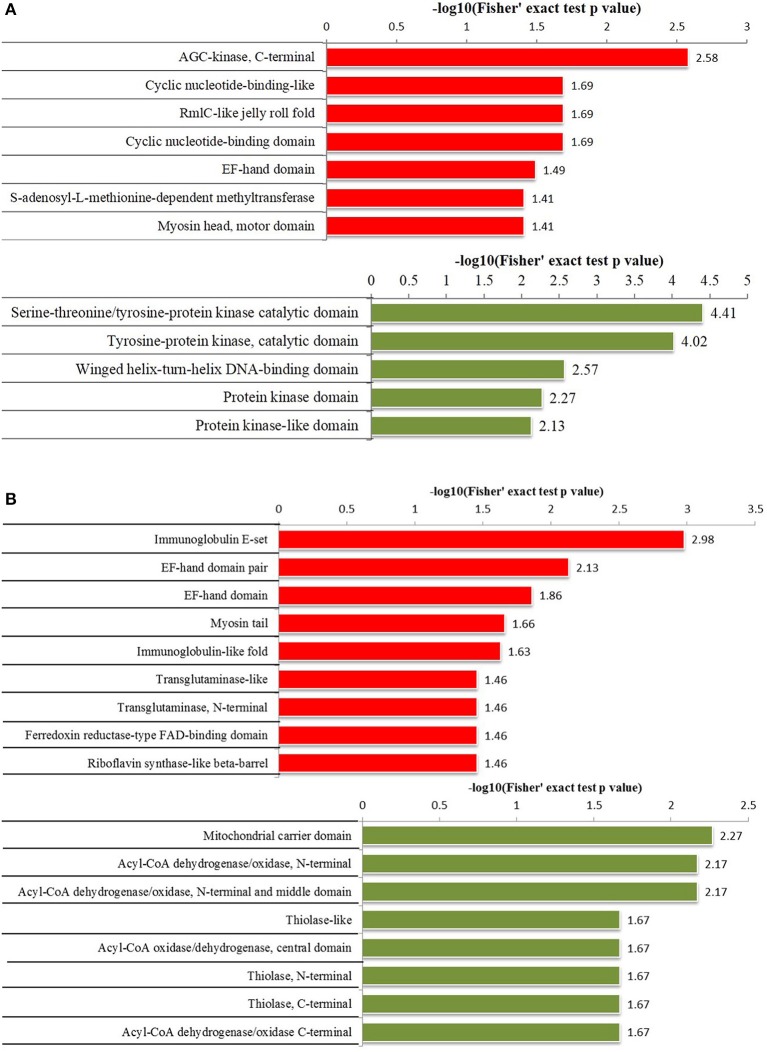
Protein domain enrichment analysis of differentially phosphorylated and acetylated proteins (p < 0.05). (A) phosphorylation. (B) Acetylation. Red, Protein domain terms for which the modification was upregulated. Green, Protein domain terms for which the modification was downregulated.